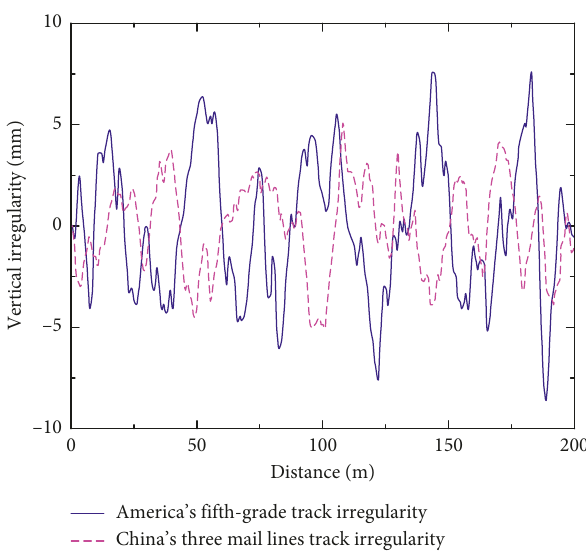
Figure 6: Vertical track irregularity in the time domain.